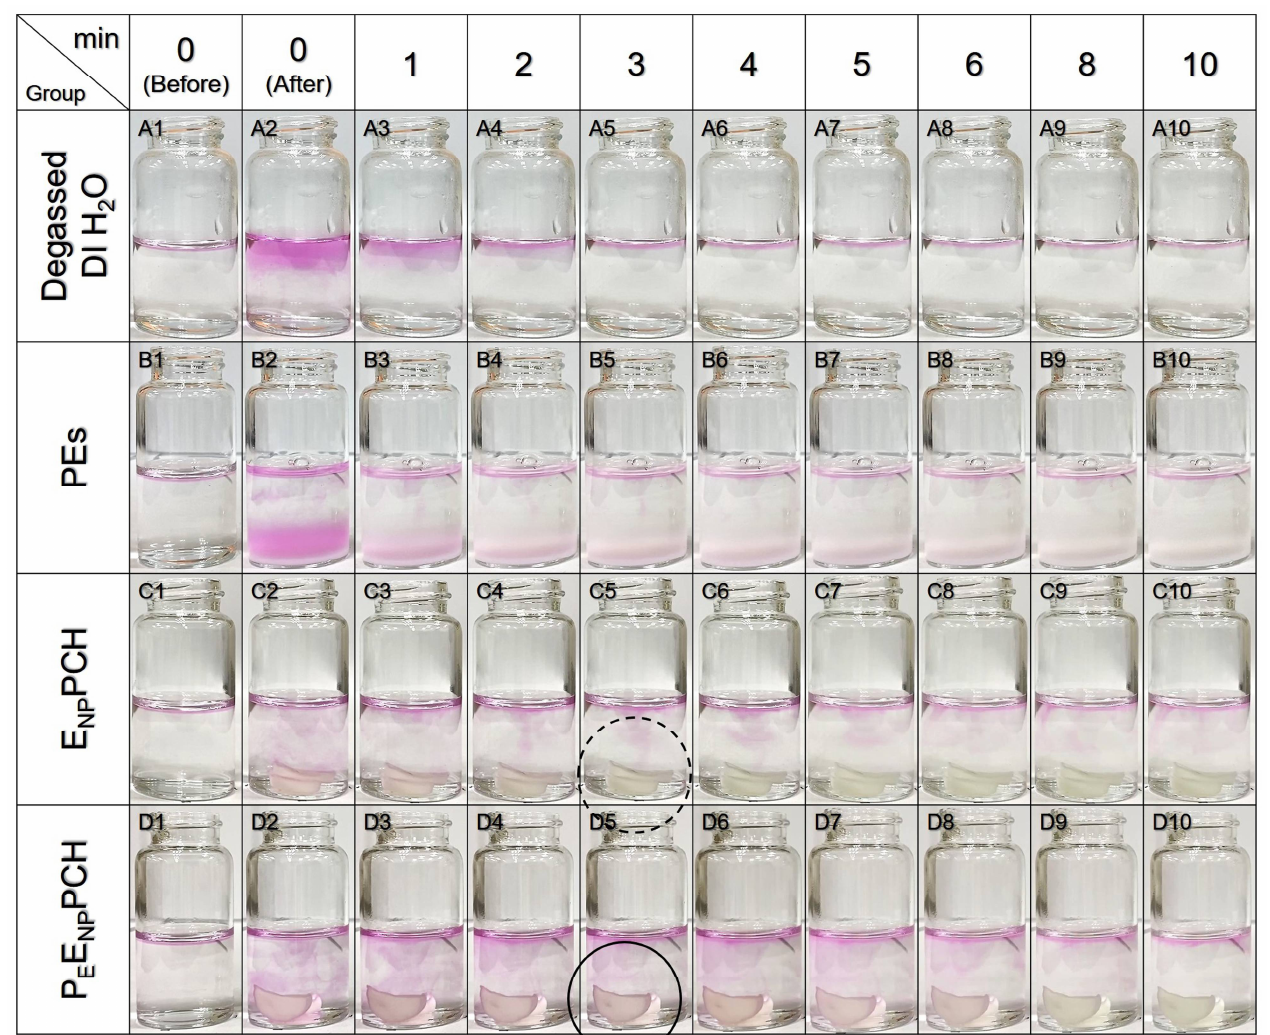
Figure 3. Assessment of the O 2 -carrying capacity of the P E E NP PCH. Images of 10 mL of RSSM before and after adding 100 µ L of degassed DI water (Row A), 100 µ L of PEs (Row B), E NP PCH ( V = 0.5 cm 3 ; Row C), or P E E NP PCH ( V = 0.5 cm 3 ; Row D) for 10 min. The doses of PFOB in the PEs (25 mg/mL); or EGF (60 g/mL) and PHMB (2000 ppm) in the E NP PCH, were all equal to those in the P E E NP PCH. The pink color denotes the presence of oxygen in the region. The E NP PCH was colorless while the P E E NP PCH retained pink at the 3rd min as indicated by dashed and solid circles, respectively.